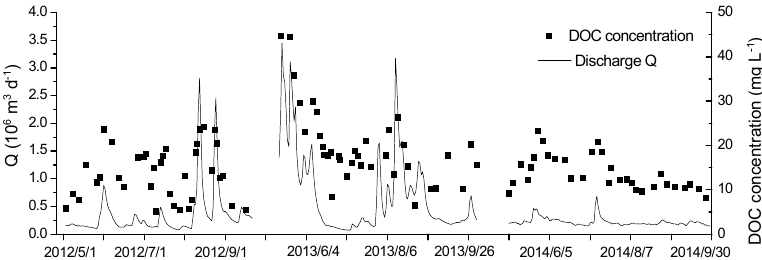
Figure 3. Dissolved organic carbon (DOC) concentrations and discharge ( Q ) observed during the growing seasons of 2012 to 2014.